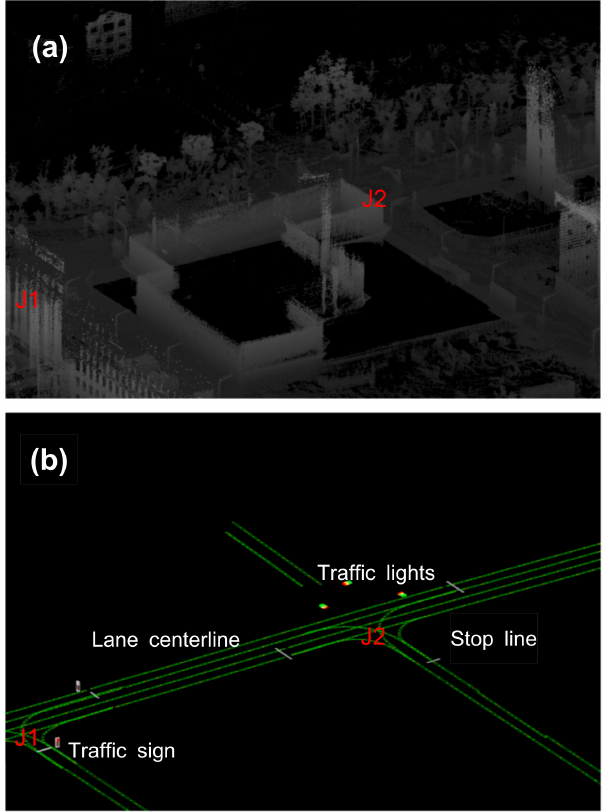
Figure 2. Shape comparison of ( a ) pointcloud and ( b ) vector data in the map. J denotes a junction.